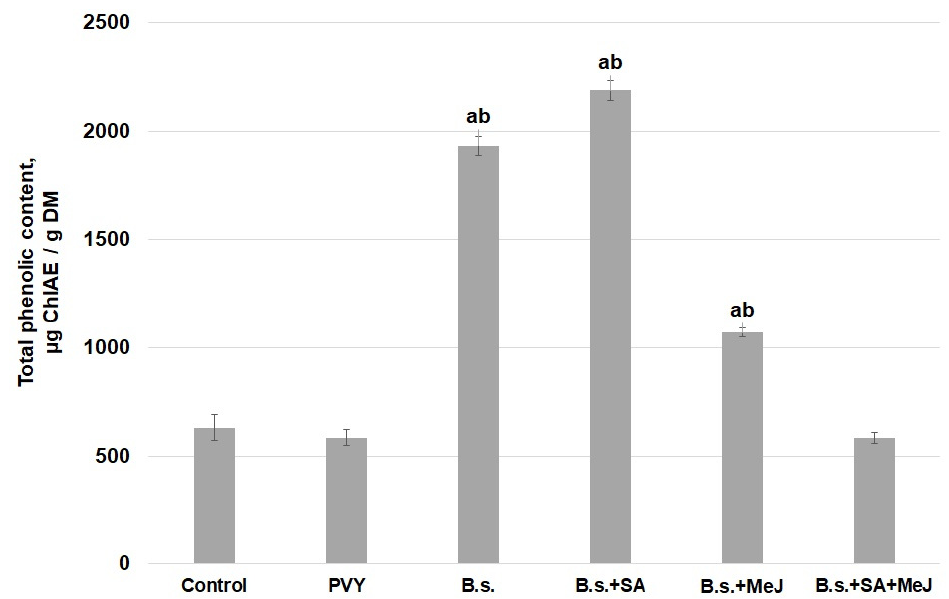
Figure 4. Effect of PVY infection and the mixture of B. subtilis with SA and MeJ application under soil water deficiency on total phenolic contents. Control—health plants; PVY—infected with PVY plants; B.s.— B. subtilis + PVY; B.s. + SA— B. subtilis + salicylic acid + PVY; B.s. + MeJ— B. subtilis + methyl jasmonate + PVY; B.s. + MeJ + SA— B. subtilis + salicylic acid + methyl jasmonate + PVY. a—indicates means that are statistically significantly different from the control, b—indicate means that are statistically significantly different from the PVY.